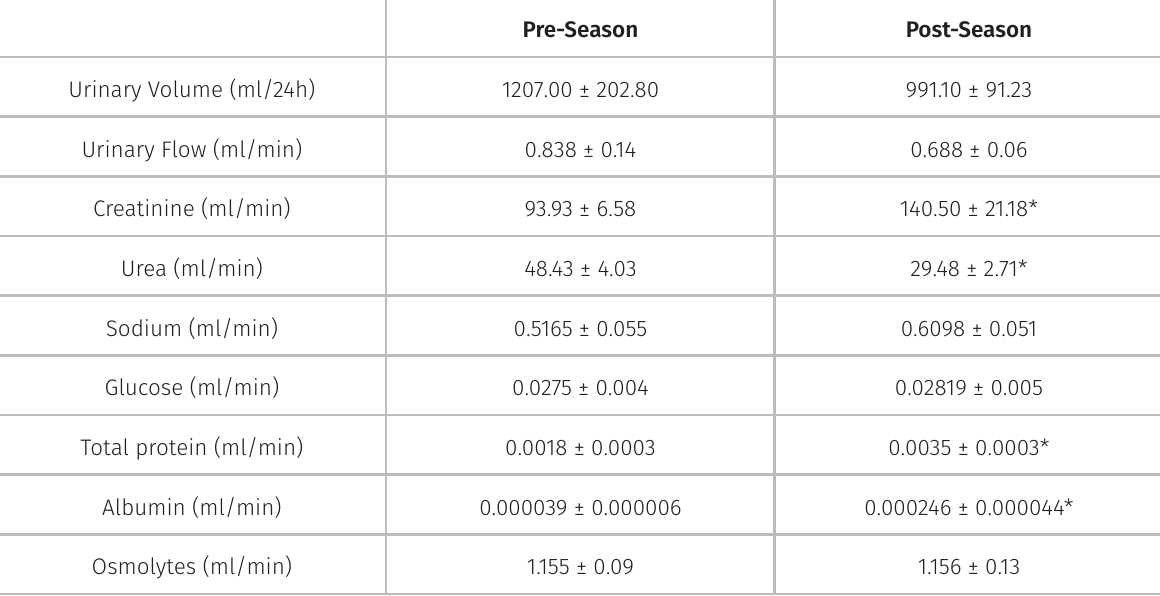
Table III. Renal solute clearances and urinary flow (Mean ±